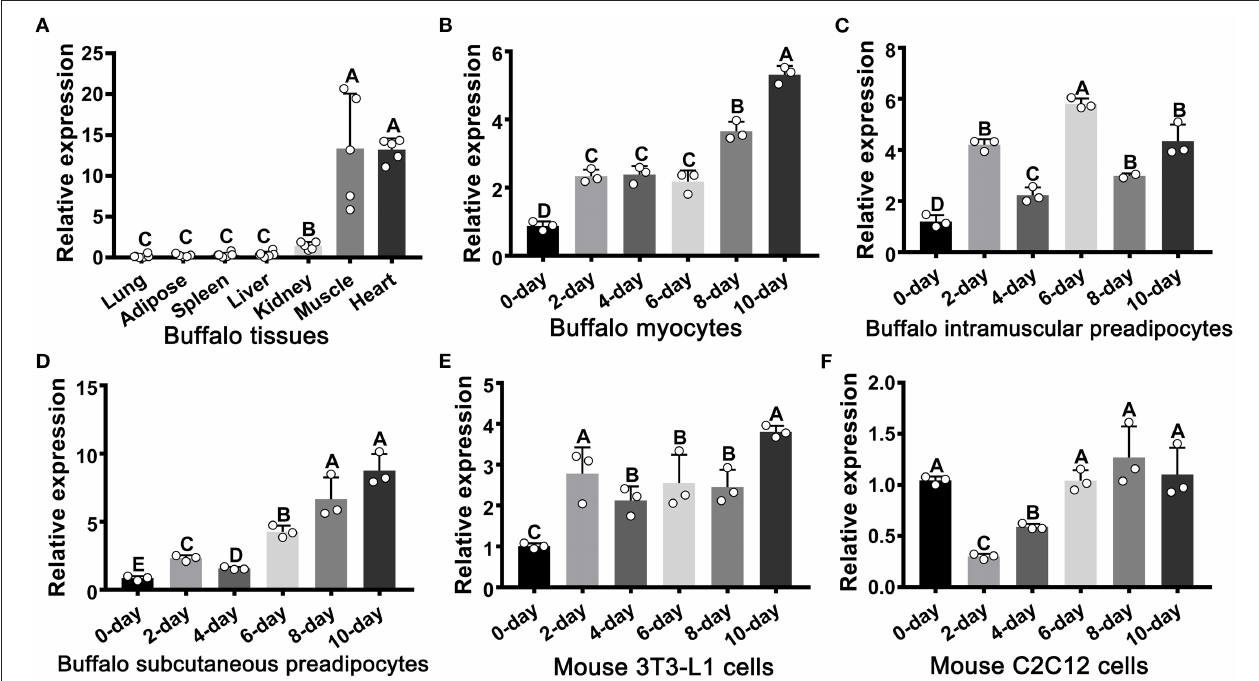
FIGURE 1 | The mRNA expression profile of FATP1 in tissues and cells as determined by RT-qPCR. (A) The tissue expression profile of FATP1 in the buffalo. (B–D) Expression dynamics of FATP1 during adipogenic differentiation in buffalo myocytes, intramuscular preadipocytes, and subcutaneous preadipocytes. (E,F) Expression dynamics of FATP1 during adipogenic differentiation in mouse 3T3-L1 and C2C12 cells. Data are presented as means ± SD; lowercase letters indicate a significant difference ( p < 0.05), uppercase letters indicate a highly significant difference ( p < 0.01).